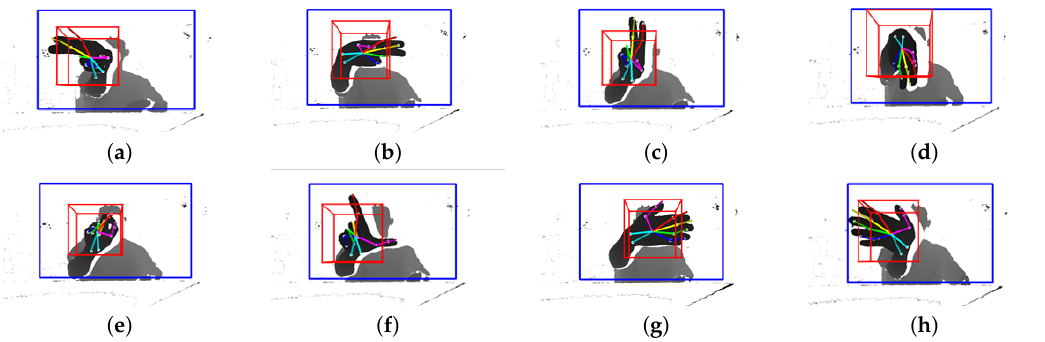
Figure 7. 8 hand gestures. ( a ) Left; ( b ) Right; ( c ) Up; ( d ) Down; ( e ) Zoom-out; ( f ) Zoom-in; ( g ) Continuous rotation right; ( h ) Continuous rotation left.